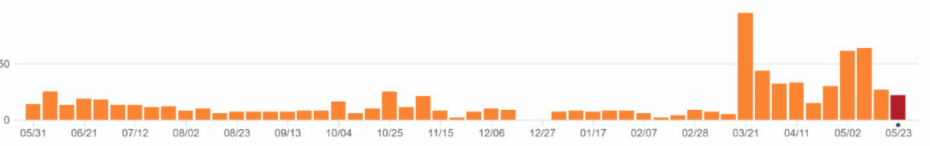
Figure 10. Number of commits of COVID-19 data